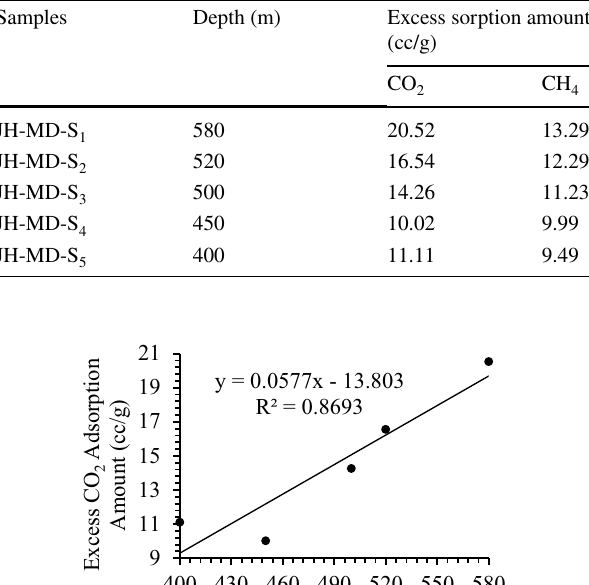
4 sorption with depth